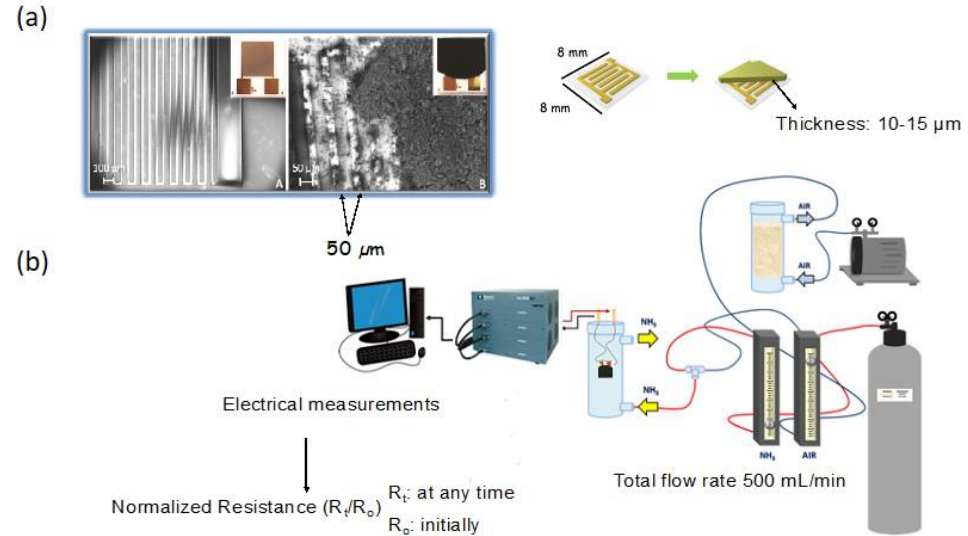
Figure 1. ( a ) A chip without and with a carbon film (upper panel) and ( b ) experimental set up to test the sensing response. Adapted with permission form Reference [20]. Copyright 2016, The Royal Society of Chemistry.